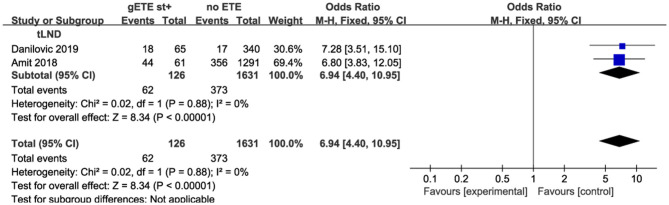
Subgroup analysis for LNM comparison between gETE st+ with no ETE.